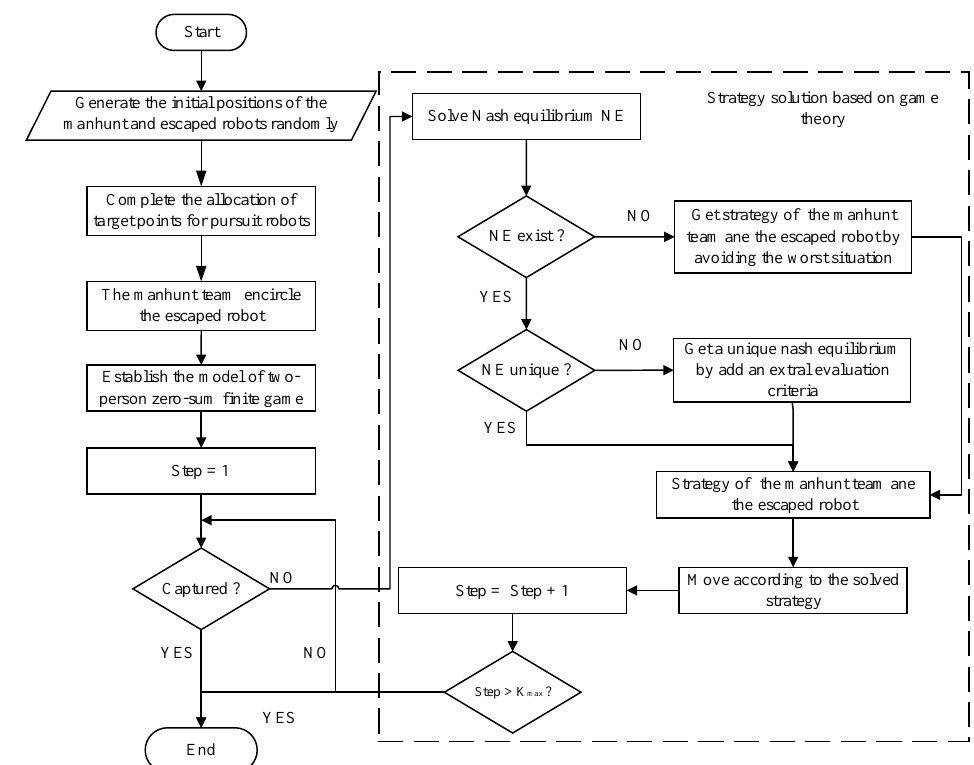
Figure 5. Multi-robot cooperative pursuit strategy.